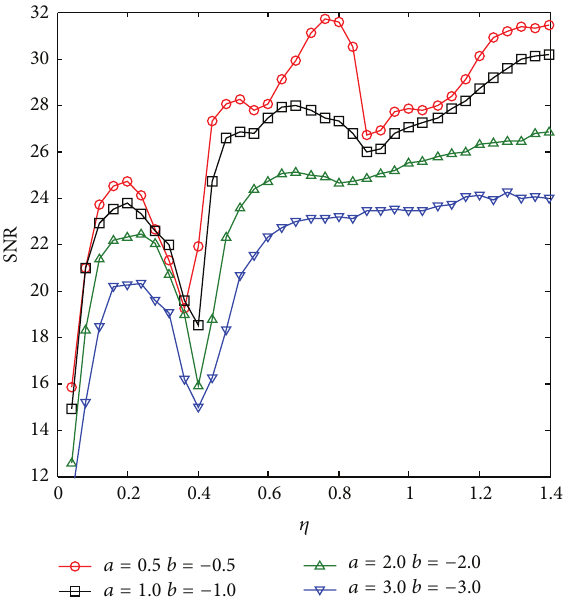
Figure 7: SNR versus the damping coefficient for the different state values of the symmetric dichotomous noise.